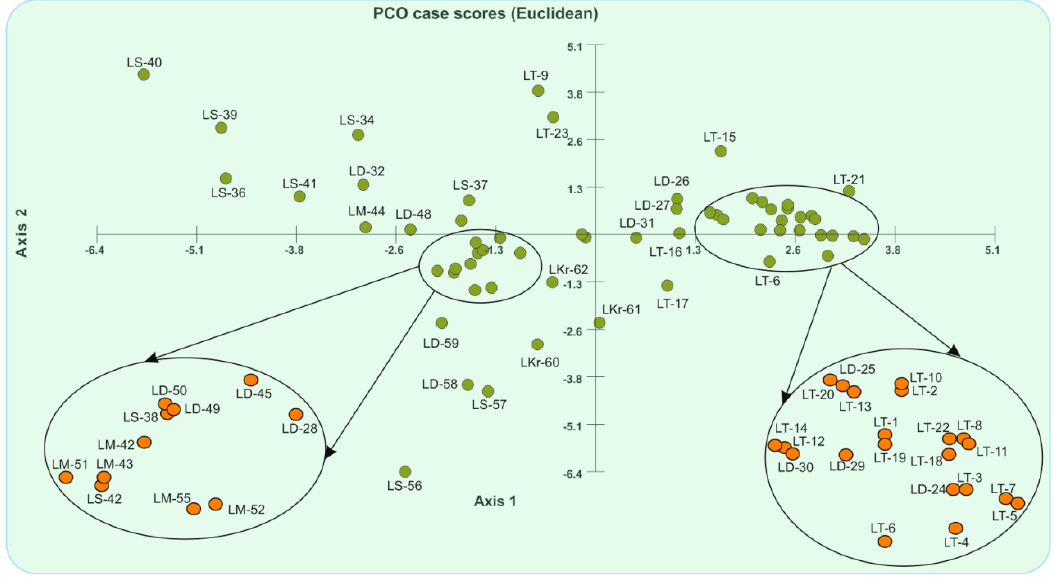
Figure 4. Principal coordinate analysis (PCoA) of Dice’s similarity matrix, carried out with Multivariate Statistical Package (MVSP) 3.21.